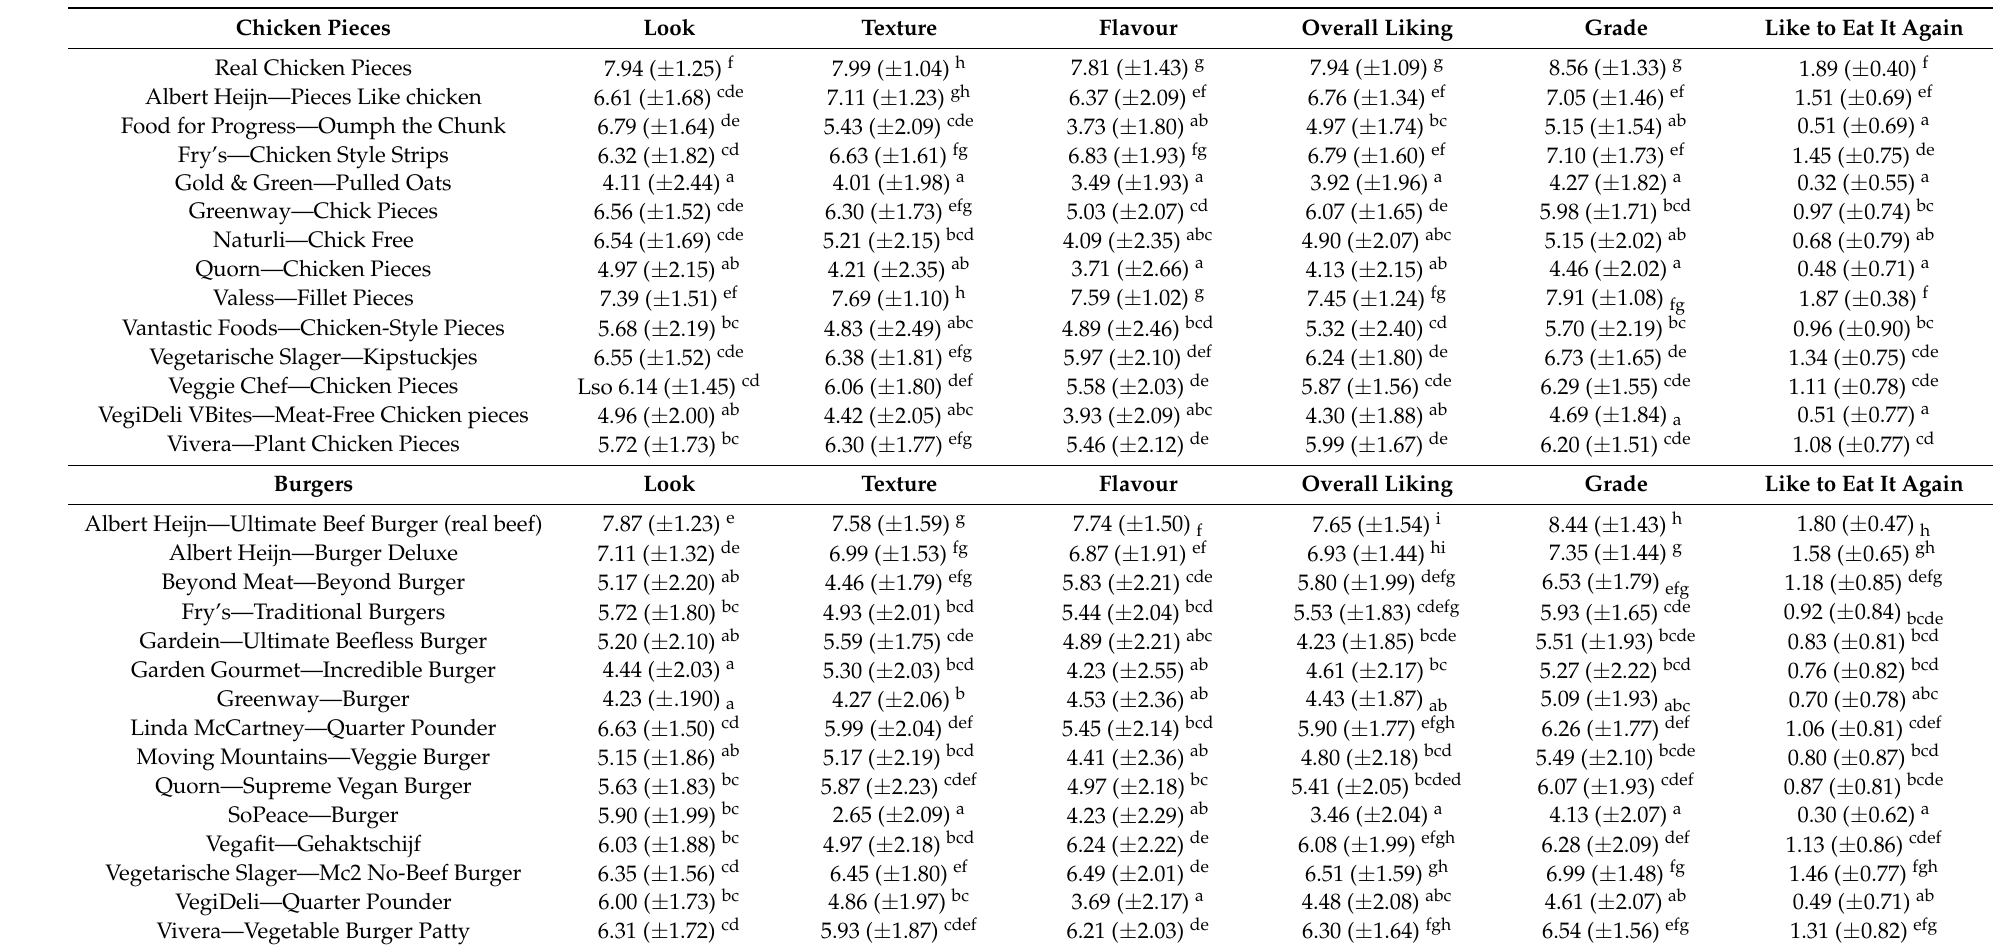
Table 6. Liking scores (scale 1–9), grade (scale 1–10), and intention to eat again (scale 0–2) for the meat analogues after preparation studied in the present research ( n =